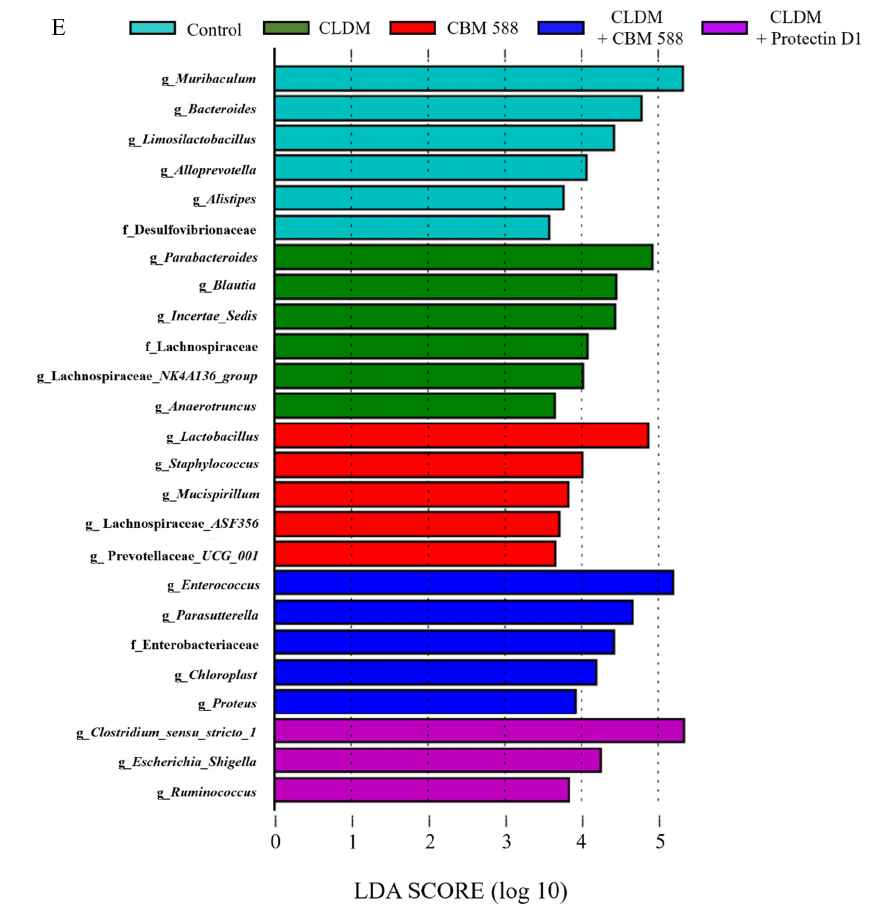
Figure 1. CBM 588 and protectin D1 both modulate gut microbiome following antimicrobial administration. ( A ) Experimental design of in vivo study with 9-week-old ICR mice. Mice were divided into groups as follows and received CBM 588 and/or CLDM via sonde, protectin D1 by intraperitoneal administration for 4 d: control group (Control), CLDM ad- ministration group (CLDM), CBM 588 administration group (CBM 588), CBM 588 combination group (CBM588 + CLDM) and protectin D1 combination group (protectin D1 + CLDM). ( B ) Bacterial compositions in different experimental groups at the phylum level. The vertical axis shows relative abundance (%) per the whole ( n = 5 in each group). ( C ) The mean Chao1 index between each group. The vertical axis shows Chao 1 index. The box and whiskers represent the smallest and largest values, with the median in the center of each box ( n = 5). The probability was considered statistically significant at p < 0.05. *: p < 0.05 compared with control. ( D ) Principal coordinates analysis (PCoA) derived from unweighted UniFrac distances ( n = 5). ( E ) LEfSe analysis of the gut microbiome composition. Histogram of the LDA scores (log 10) > 4.0 and p < 0.05 reveals the most differentially abundant taxa among different reproductive stages. g_ means genus, f_ means family ( n = 5).